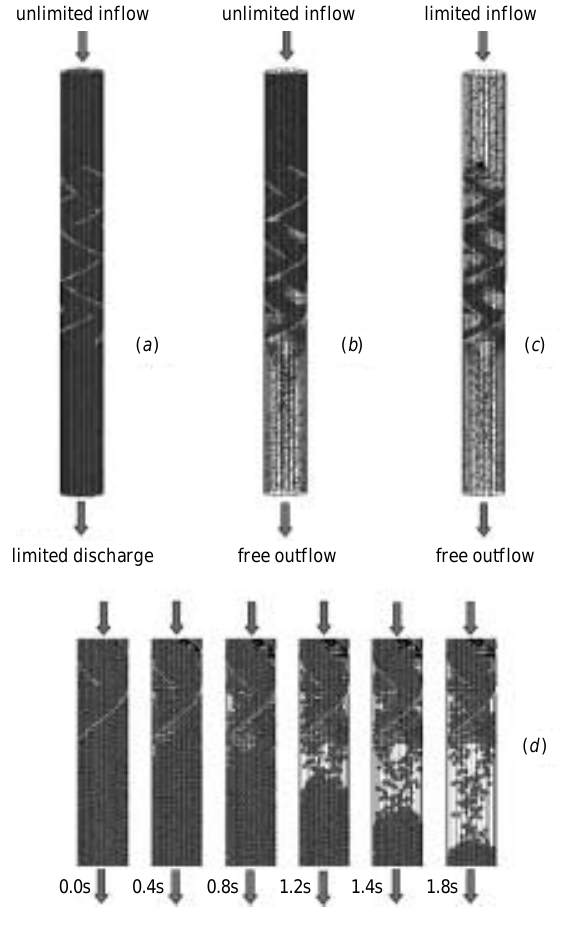
Characteristic flow regimes in gravity mixer tubes with motionless mixers in the middle tube section ( a ) 1 st flow regime, ( b ) 2 nd flow regime, ( c ) 3 rd flow regime, ( d ) transition between the 1 st and 2 nd